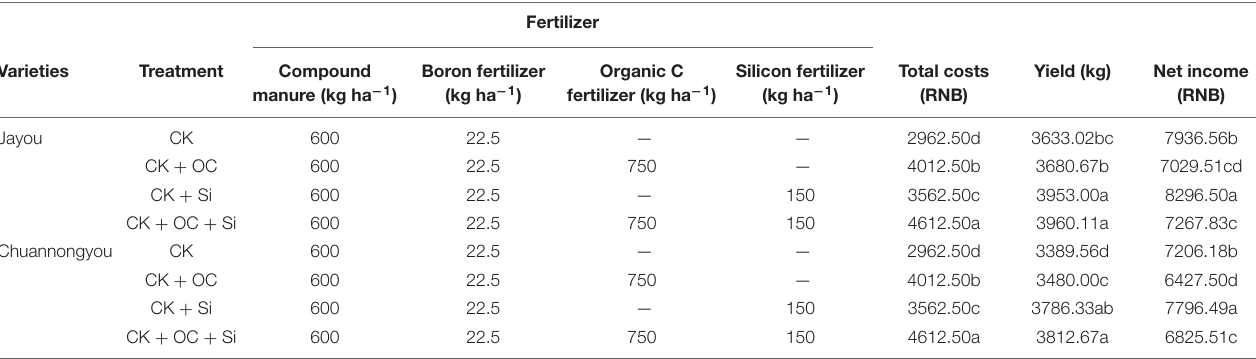
TABLE 7 | Effect of different fertilization treatments on cost and